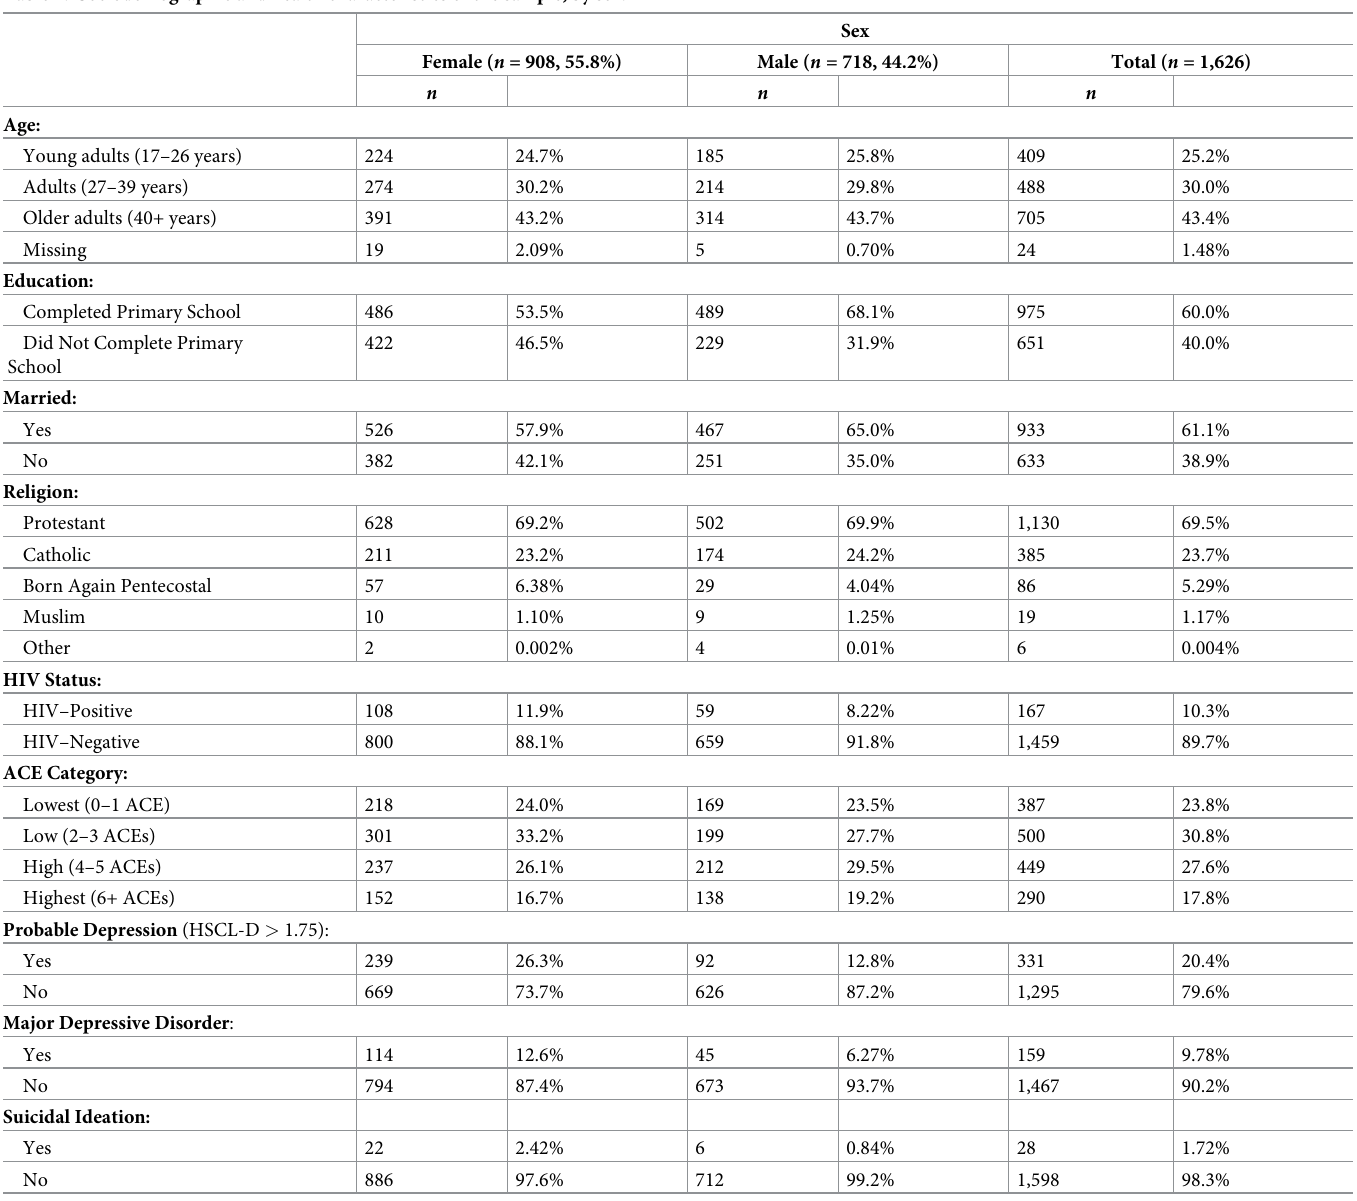
Table 1. Sociodemographic and health characteristics of the sample, by